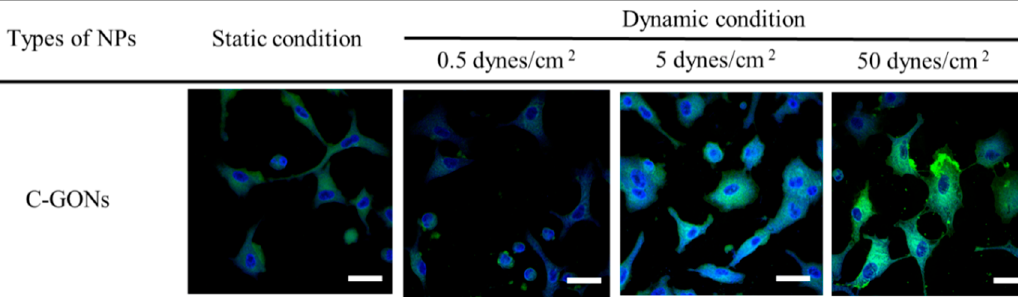
Figure 6. Confocal images of internalized GONs in A549 cancer cells after treatment with coumarin-6-loaded GONs under static or biomimetic dynamic conditions at different shear stress levels for 1 h (scale bar: 20 µm).